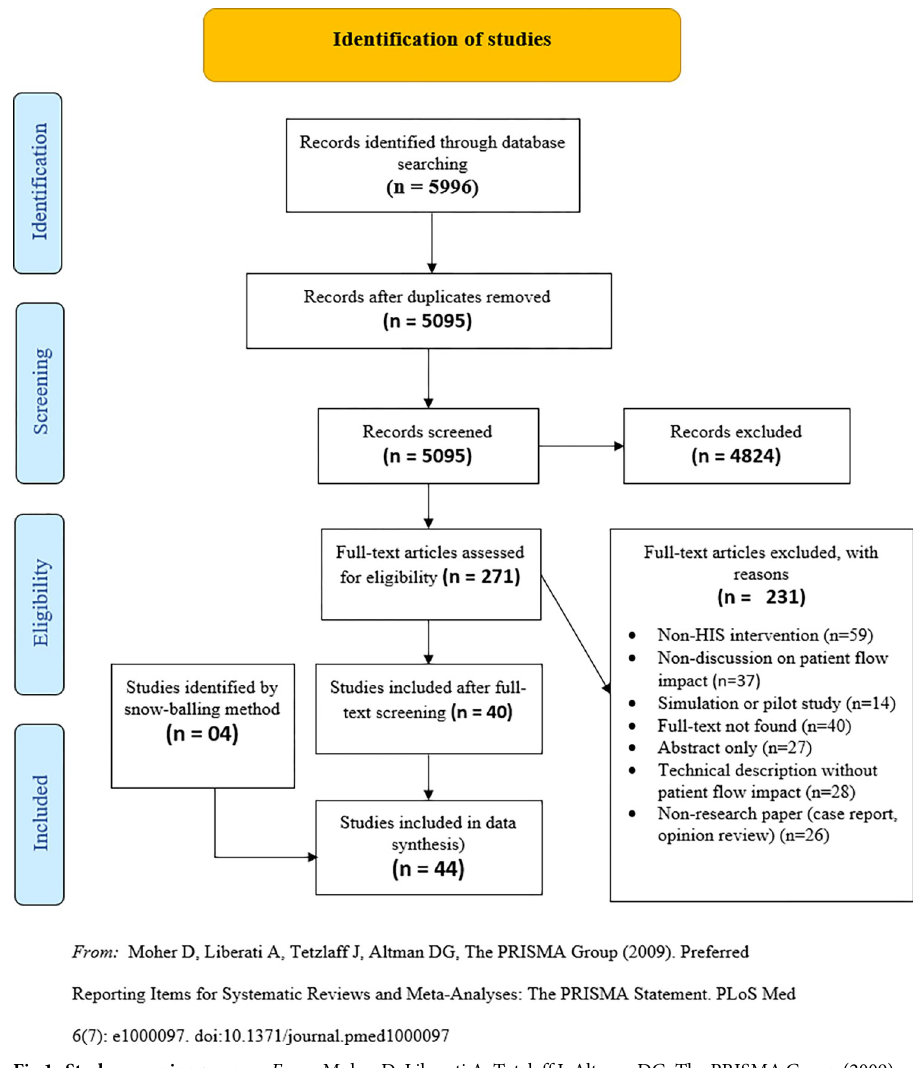
Fig 1. Study screening process. From : Moher D, Liberati A, Tetzlaff J, Altman DG, The PRISMA Group (2009). Preferred Reporting Items for Systematic Reviews and Meta-Analyses: The PRISMA Statement. PLoS Med